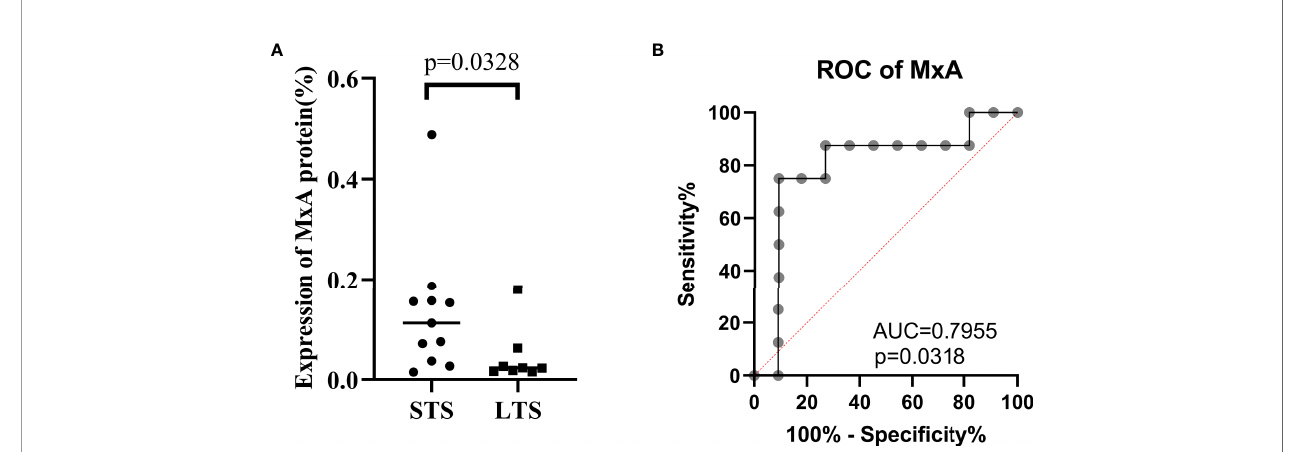
FIGURE 3 | Low MxA expression was associated long-term survival. Comparison of MxA protein expression between long-term survivors (LTS, ≥ 3-y overall survival) and short-term survivors (STS, <3-y overall survival), Wilcoxon nonparametric test (A) . Receiver operating characteristic (ROC) curve analysis for evaluating the capacity of MxA protein expression to distinguish between LTS and STS (B)